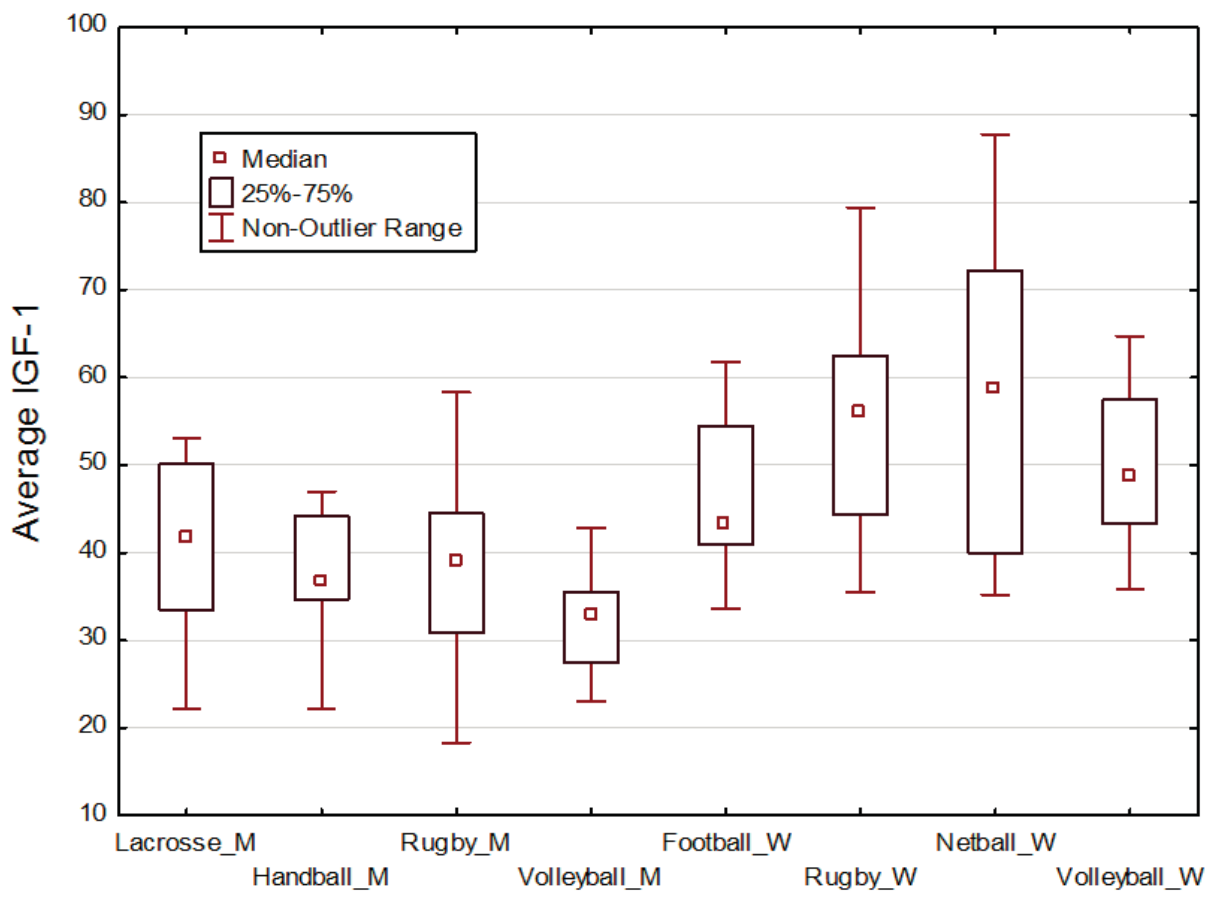
Figure 1. Box & whisker plots of IGF-1 values by type of sport. Pre-game and post-game IGF-1 values were averaged by addition and then division by 2. Men’s sports are designated by a ‘_M’ and women’s sports by a ‘_W’ after the name of the sport. Women in all types of sports ten to have higher IGF-1 values compared with